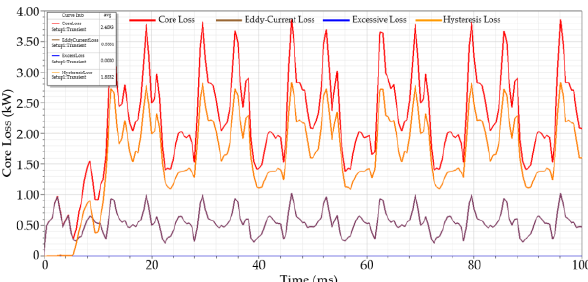
Figure 11. Simulation results of the core loss without a slow start.